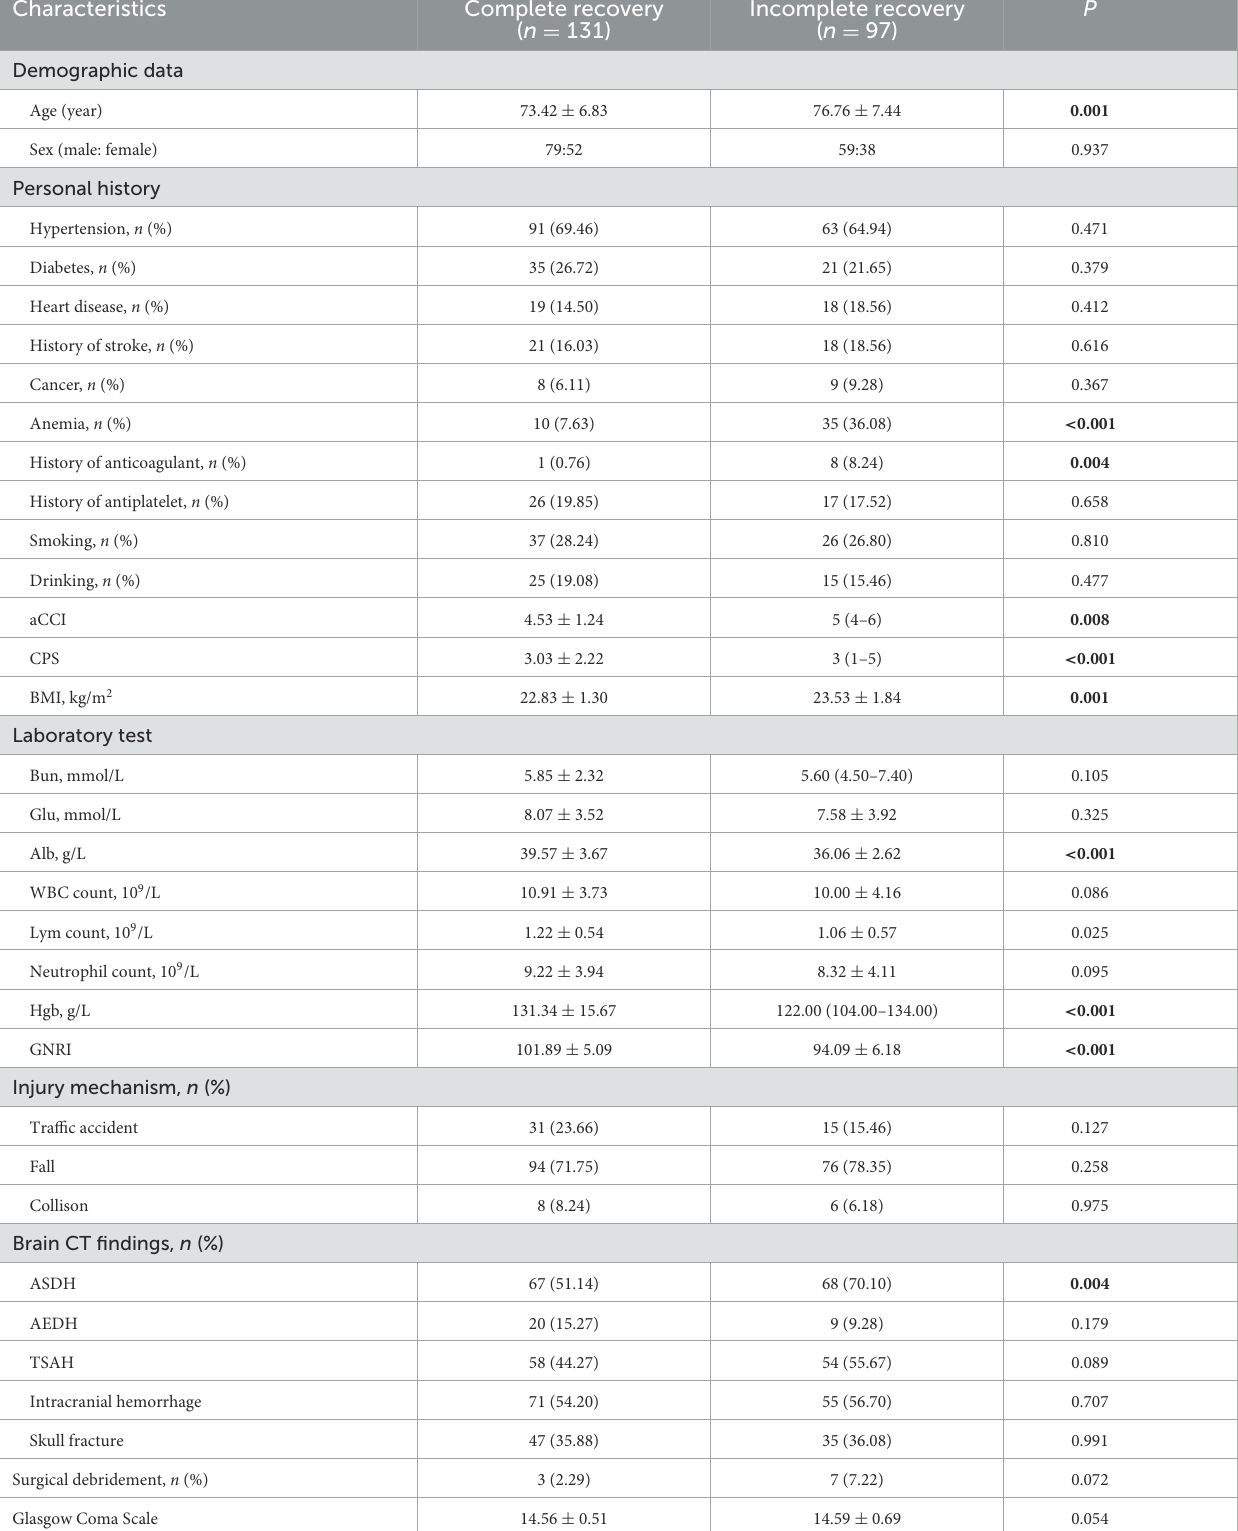
TABLE 1 Comparison of baseline characteristics between complete recovery and incomplete recovery mild traumatic brain injury